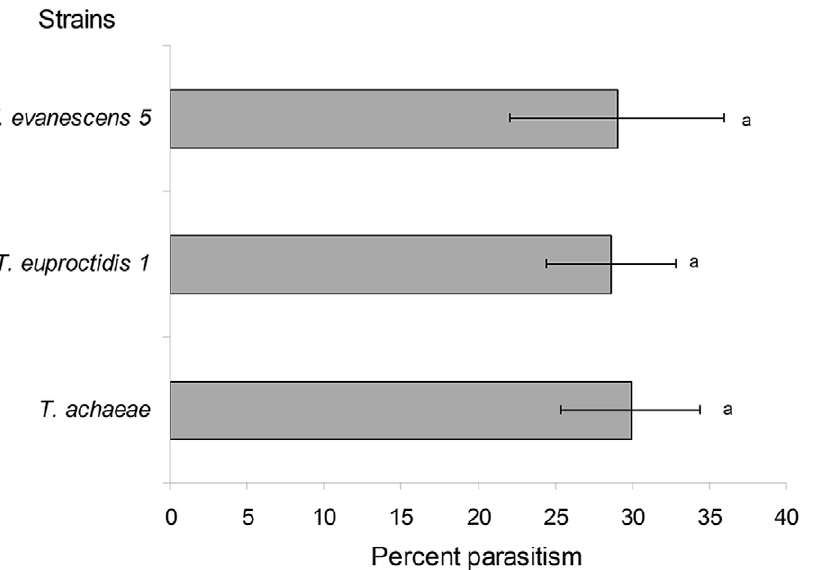
Figure 4. Parasitism of Tutaabsoluta eggs in cages in greenhouse. Percentage (mean 6 SEM) of parasitized T. absoluta eggs per Trichogramma strain in cages in the greenhouse. Histograms bearing the same letter do not differ at P , 0.05 (GLM analysis).